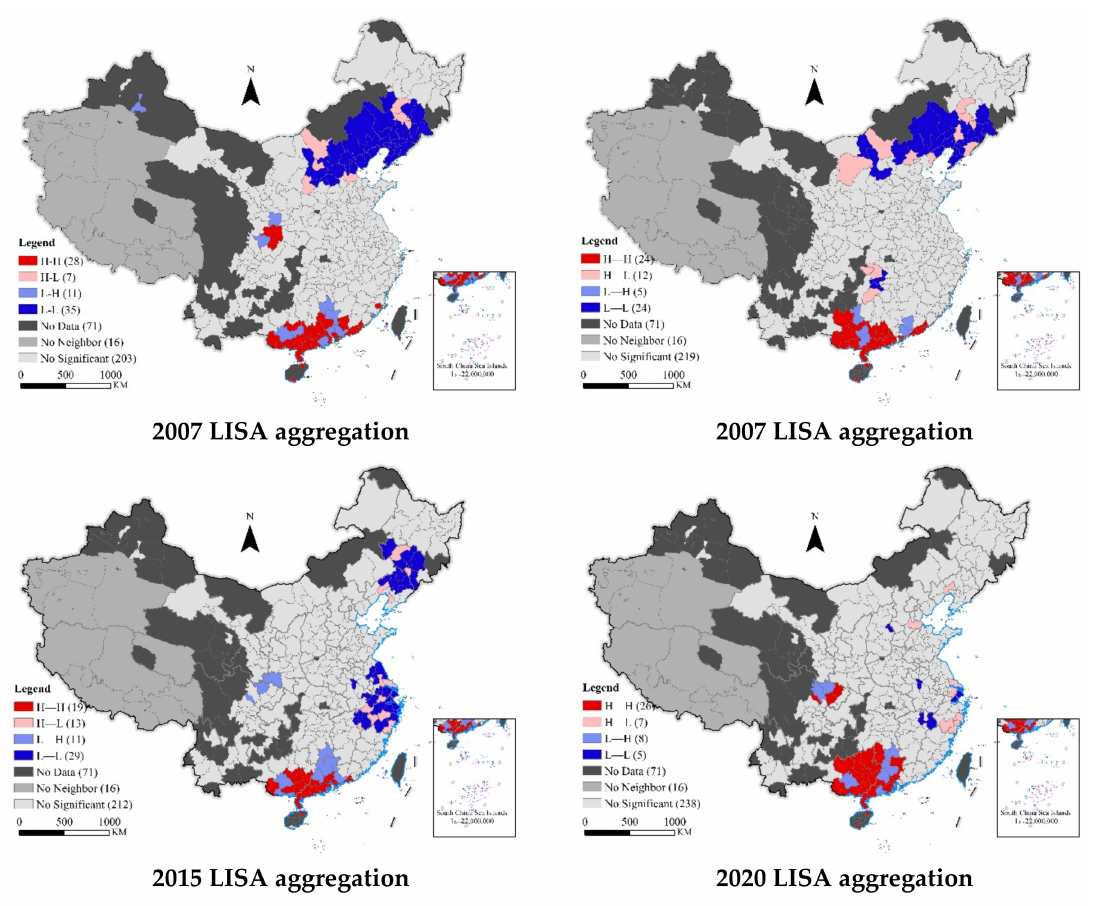
Figure 8. LISA clustering diagram of Chinese cities EWP in 2007, 2010, 2015, and 2020 using the inverse distance matrix. Note: the map is drawn according to the Standard Map Service Website of the Ministry of natural resources (map review No. GS (2020)